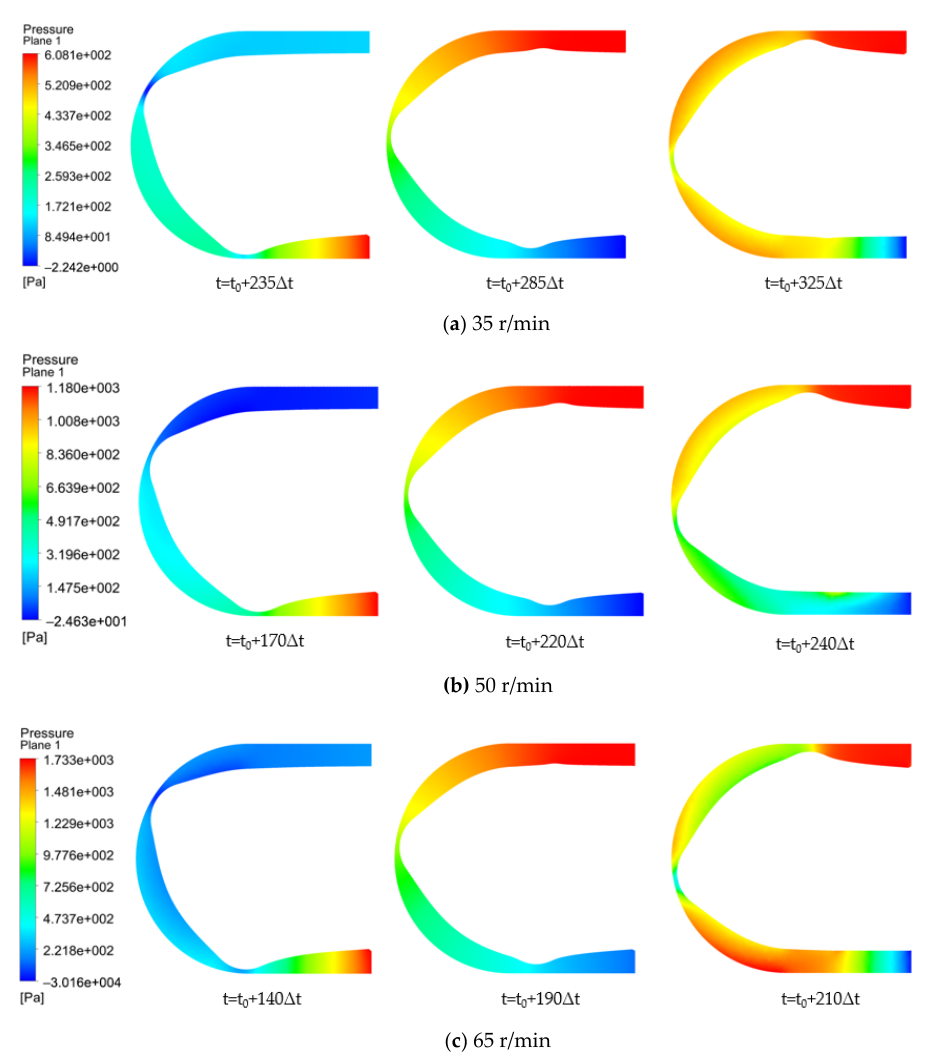
Figure 8. Flow curve of experimental and simulation results.